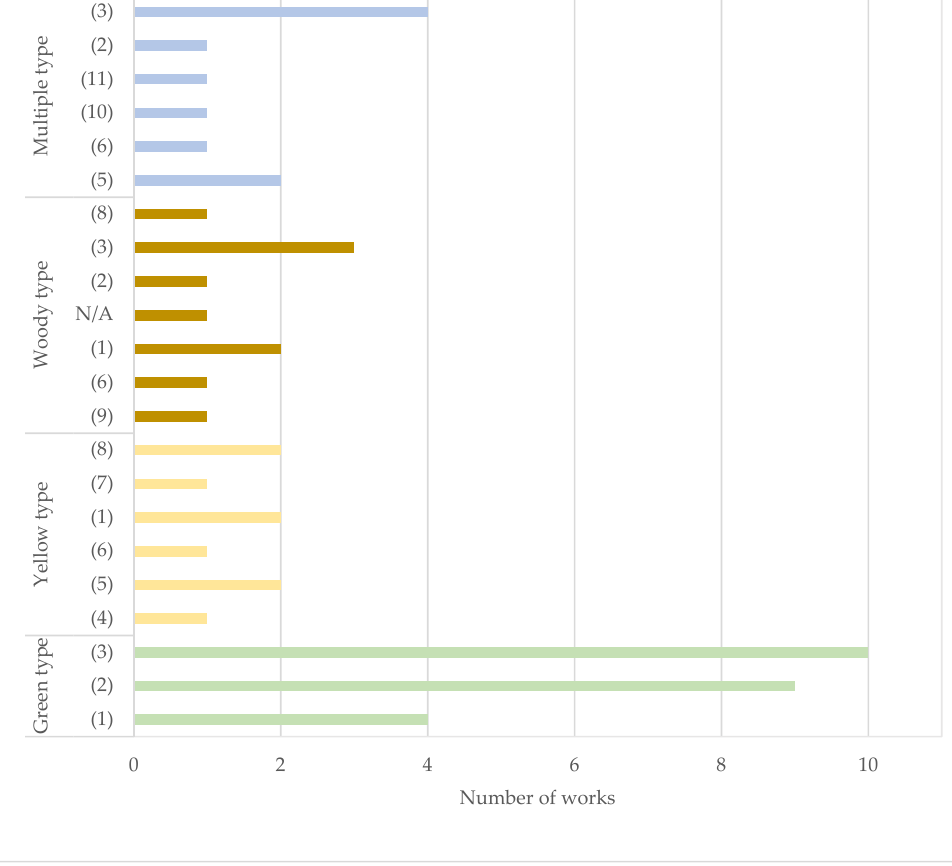
( 2 ) production; ( 3 ) production and transport; ( 4 ) collection and quantification; ( 5 ) collection and transport;